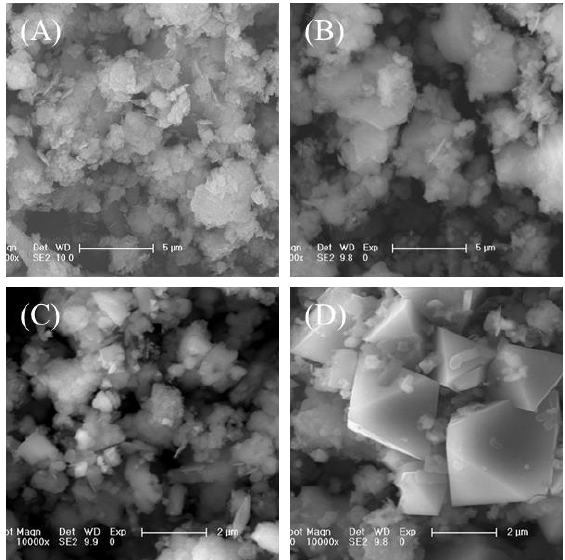
Figure 5. Scanning electron microscopy (SEM) images of ( A ) red mud, ( B ) P-120, ( C ) P-200, and ( D ) P-270.